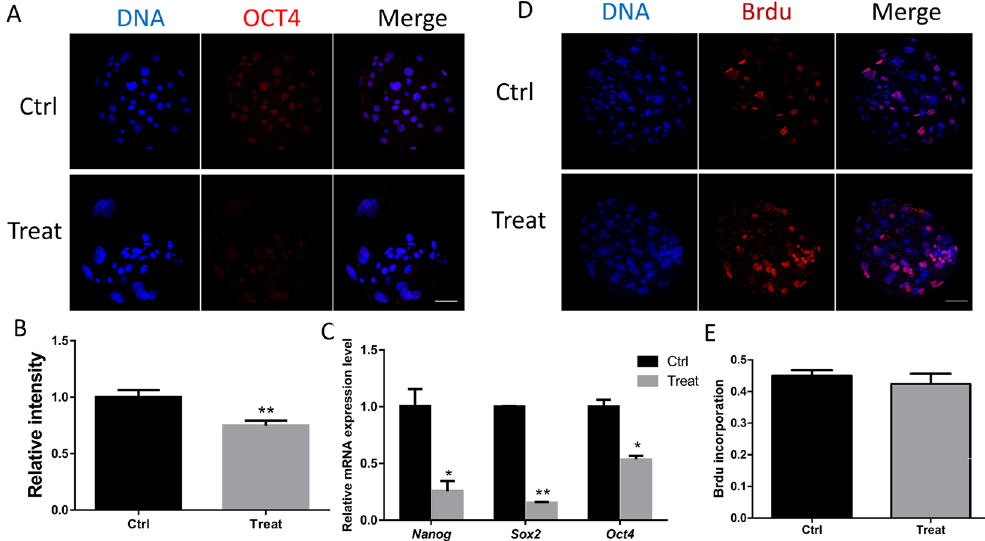
Figure 5. Effect of BPA treatment on pluripotency and differentiation. ( A ) Laser scanning confocal microscopy images of immunostaining for OCT4 in porcine blastocysts in the control and BPA treatment groups. ( B ) The relative intensity of OCT4 was measured. ( C ) The relative Oct4 , Nanog , and Sox2 mRNA expression levels are shown. ( D ) BrdU incorporation in blastocysts after BPA exposure. ( E ) Graph summarizing the relative rate of proliferation. * P < 0.05, ** P < 0.01. Ctrl, control; Treat, treatment. Scale bar: 50 μ m.